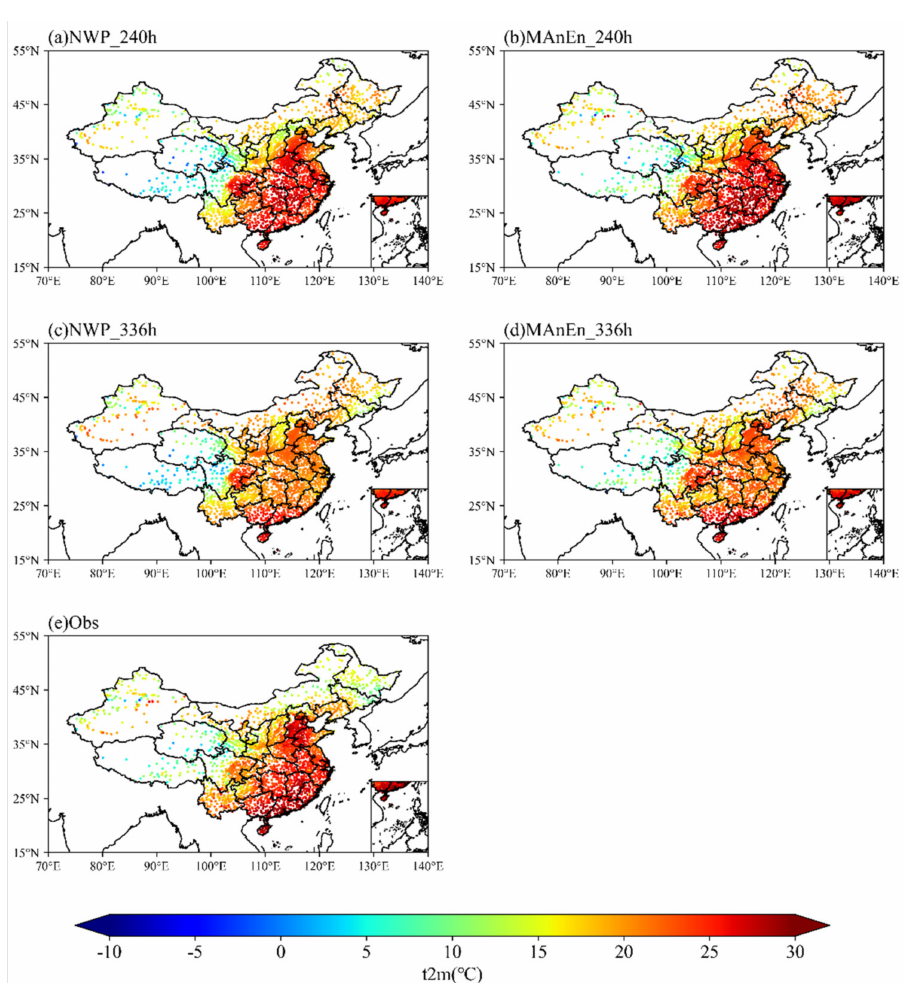
Figure 8. Observations, 240-h, and-336 h model forecasts, the analogue ensemble averaging forecasts of 2-m temperature (( a , c ): model forecasts; ( b , d ): analogue ensemble mean forecasts; ( e ): observations) at 00:00 UTC on 5 June